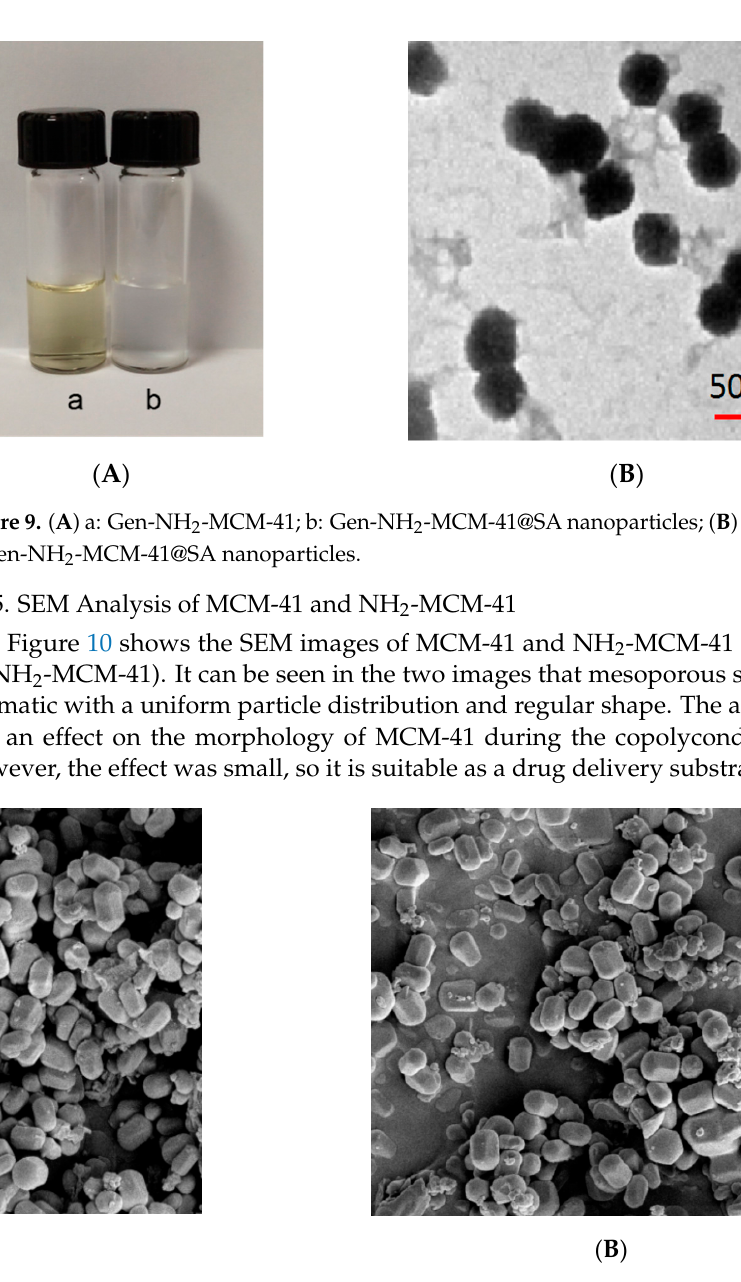
Figure 8. The particle size of Gen-NH 2 -MCM-41 ( A ) and Gen-NH 2 -MCM-41@SA nanoparticles ( B ).